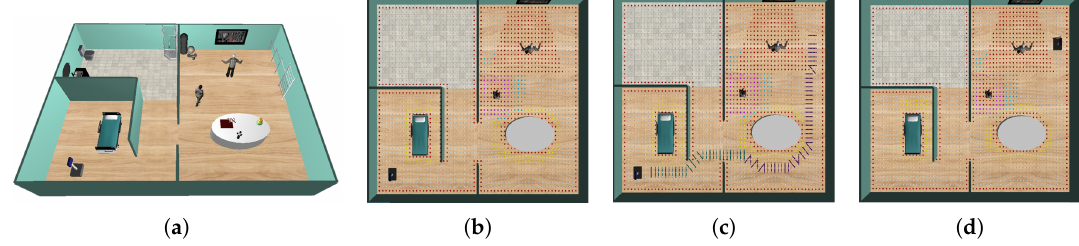
Figure 14. First use case: ( a ) 3D view of the simulated scenario; ( b ) social interaction spaces, both for people (the senior and the caregiver) and the objects in the CPS-AAL; ( c ) path planned by the robot in the CPS-AAL; and ( d ) SAR’s pose at the end of the first use case. Table 4. Results of the social navigation framework for the social robot in the first use case. A detailed description of the metrics and a brief discussion can be found in the